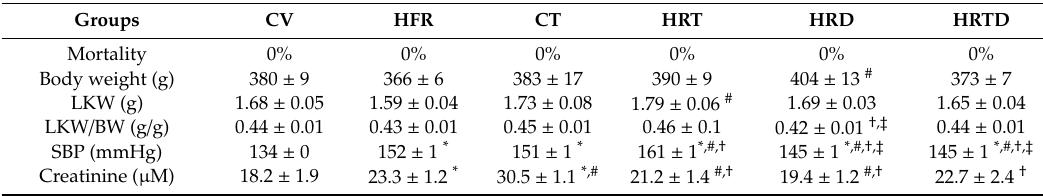
Figure 1. Experimental protocol used in the current study. CV = control rats received regular diet and vehicle; HFR = rats received high-fructose diet; CT = rats received regular diet and TCDD exposure; HRT = rats received high-fructose diet and TCDD exposure; HRD = rats received high-fructose diet and DMB treatment; HRDT = rats received high-fructose diet, TCDD exposure, and DMB treatment; TCDD = 2,3,7,8-tetrachlorodibenzo-p-dioxin; DMB = 3,3-Dimethyl-1-butanol. Table 1. Morphological and biochemical values.